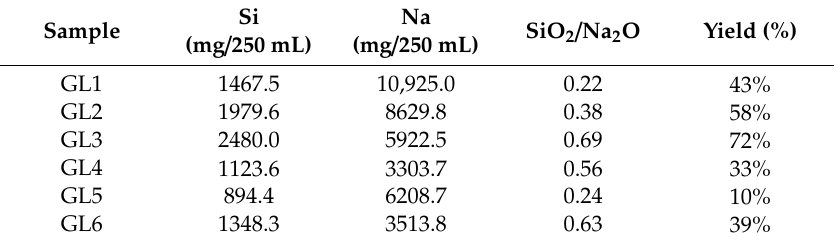
Table 6. Composition of the liquid product coming from glass dissolution.